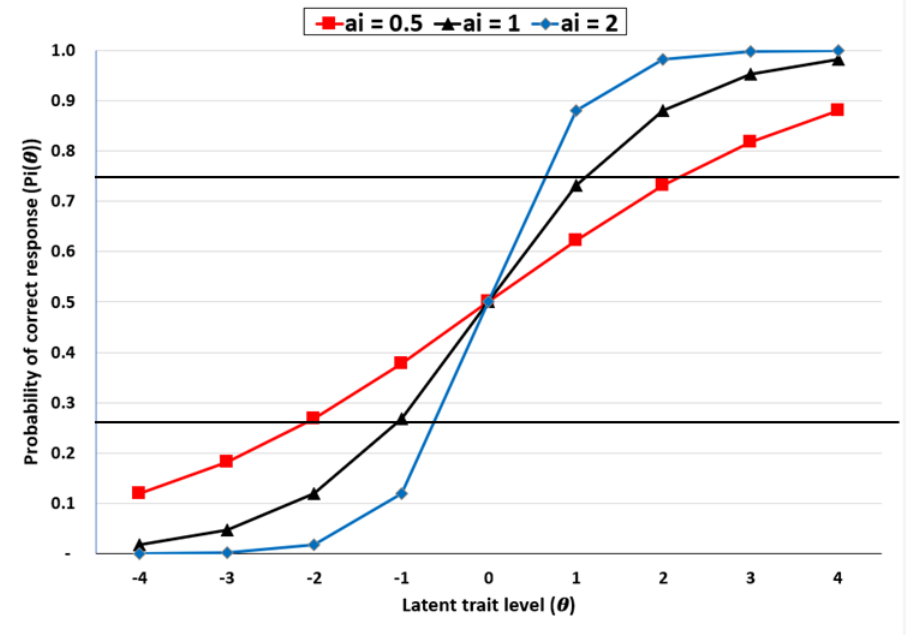
Figure 3. Item characteristic curves, IRT 2PL model: difficulty coefficient b = 0 for all items.